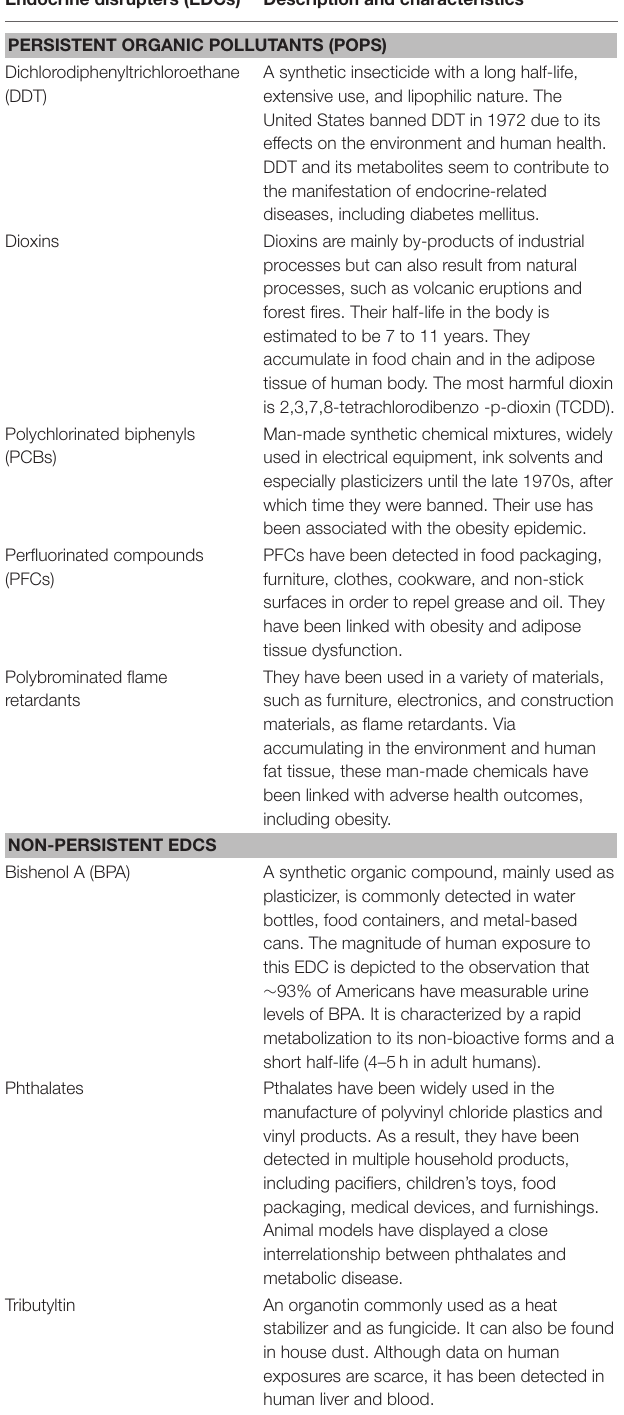
TABLE 1 | Endocrine disrupters (EDCs) with documented metabolism-disrupting effects. Endocrine disrupters (EDCs) Description and